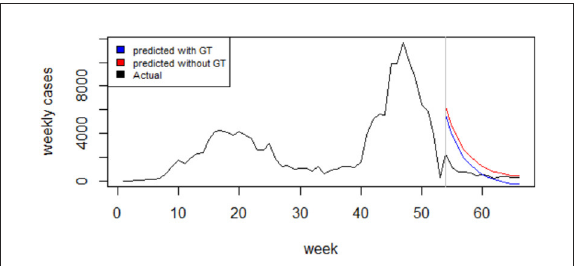
FIGURE5 l Forecasting of the optimal ARIMA Model (red curve) compared to the Google Trends enhanced Model (blue curve) and to the actual weekly COVID-19 cases (black